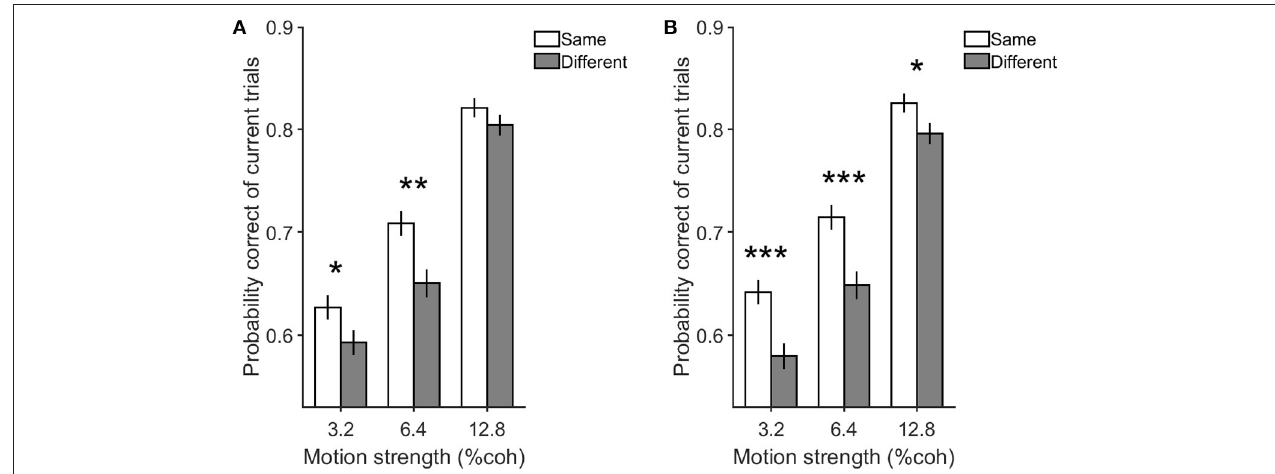
FIGURE 8 | Simulation and behavioral data for the previous decision effect on the current one in the same and different decision conditions. Either panel indicates the performance of the current trials with motion strengths of 3.2, 6.4, and 12.8% when previous trials have low motion strengths of 0 and 3.2%. (A) is the simulation data by model z and (B) is the experimental data. Error bars indicate SE (Standard Error). Wilcoxon rank-sum test is used to test the significance of the differences, * p < 0.05, ** p < 1E − 2, *** p < 1E −